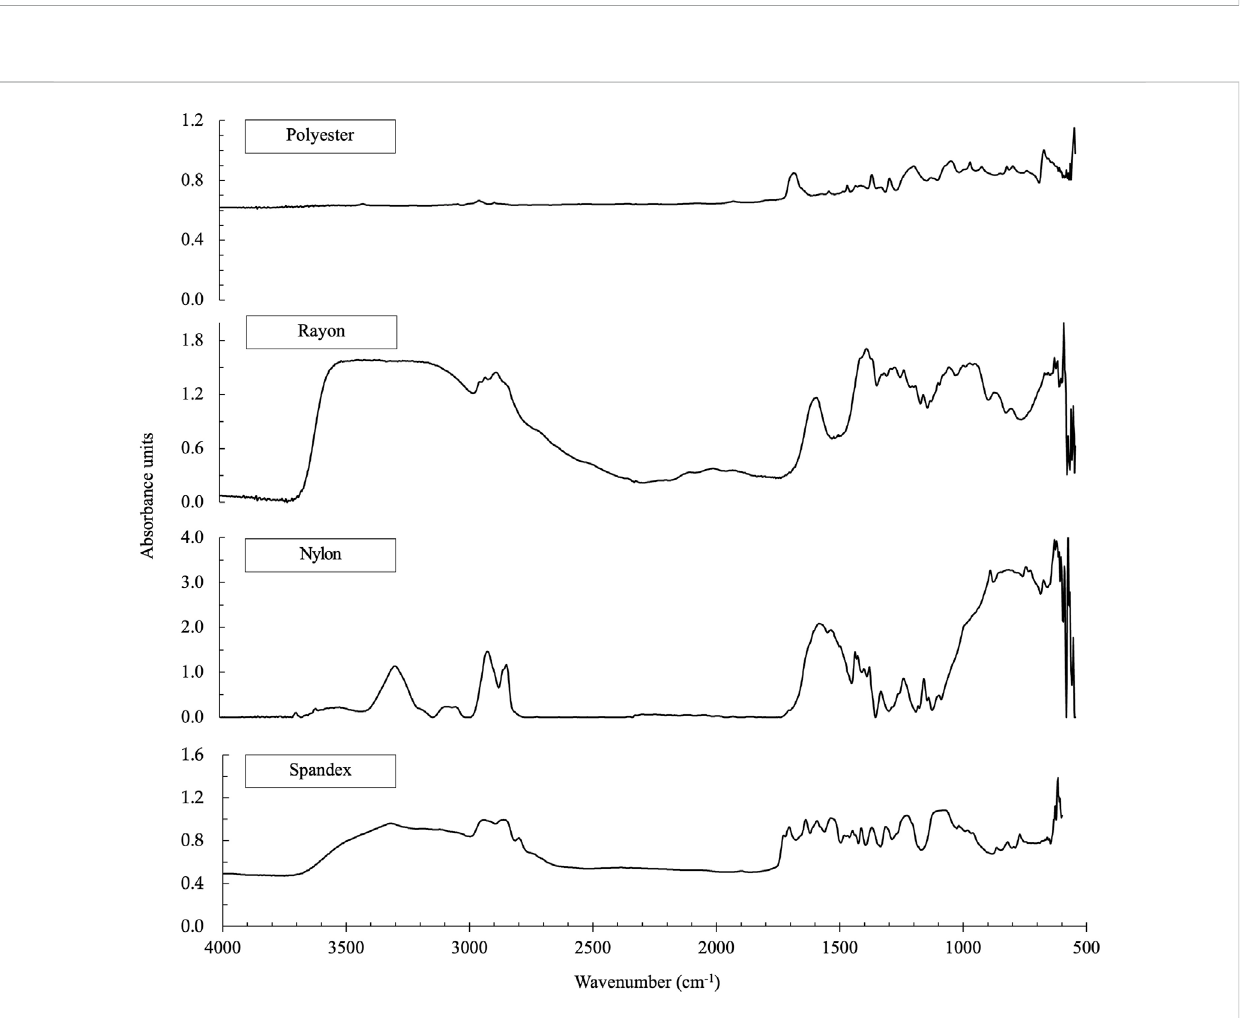
FIGURE 7 Polymer type spectrum from the FTIR analysis in this study. The FTIR spectra show microplastic types (e.g., polyester, rayon, nylon, and spandex).